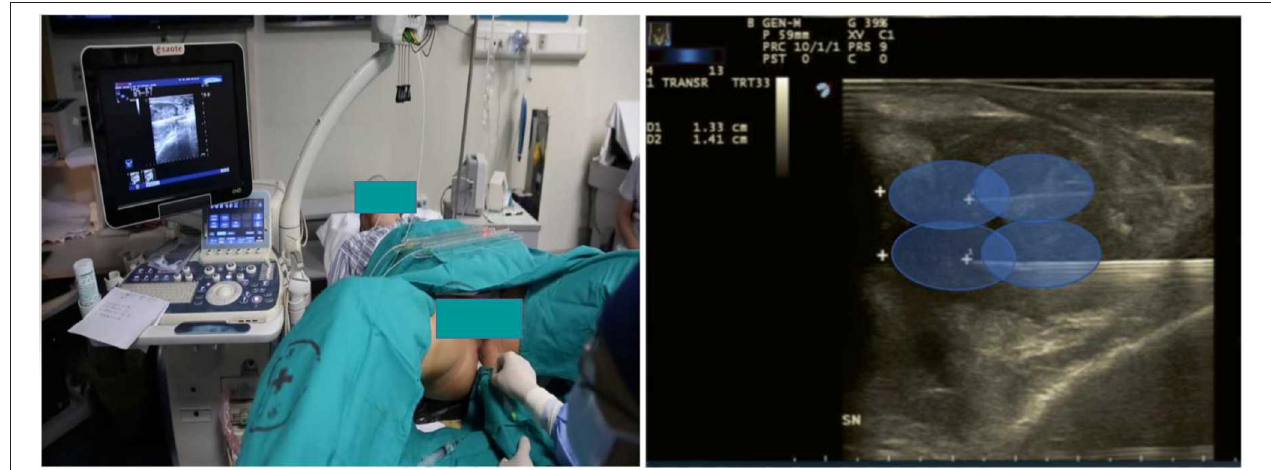
FIGURE 2 | Patient position and needle positioning. The needle was inserted into prostate under guidance of TRUS and performed oval thermal ablation scope.